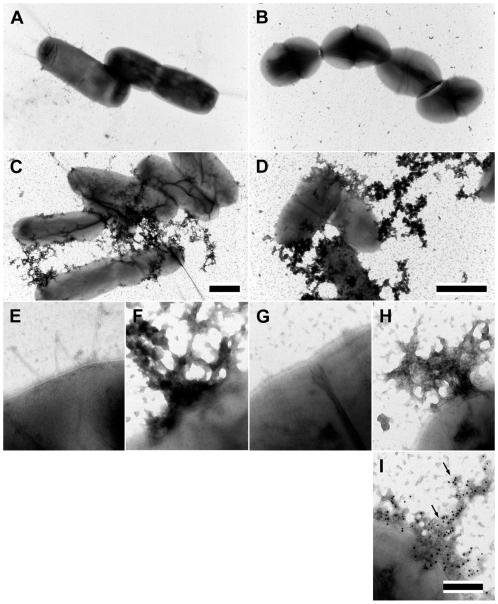
Electron microscopic analysis of E. coli and S. pyogenes bacteria treated with PCI.
E. coli (A and C) and AP1 (B and D) bacteria before (A and B) and after (C and D) treatment with PCI 4 µM were subjected to negative staining electron microscopy (bar = 1 µm). At higher magnification, extensive membrane disruption and extravasations of cytoplasmic components is seen in PCI-treated E. coli (F) and AP1 (H) bacteria. Untreated E. coli (E) and AP1 (G) bacteria served as control (bar = 200 nm). (I) AP1 bacteria were incubated with PCI followed by incubation with a gold-labeled reversed primer coding for M1 protein (arrows), one of the most abundant proteins on the surface of AP1 bacteria (bar = 200 nm).